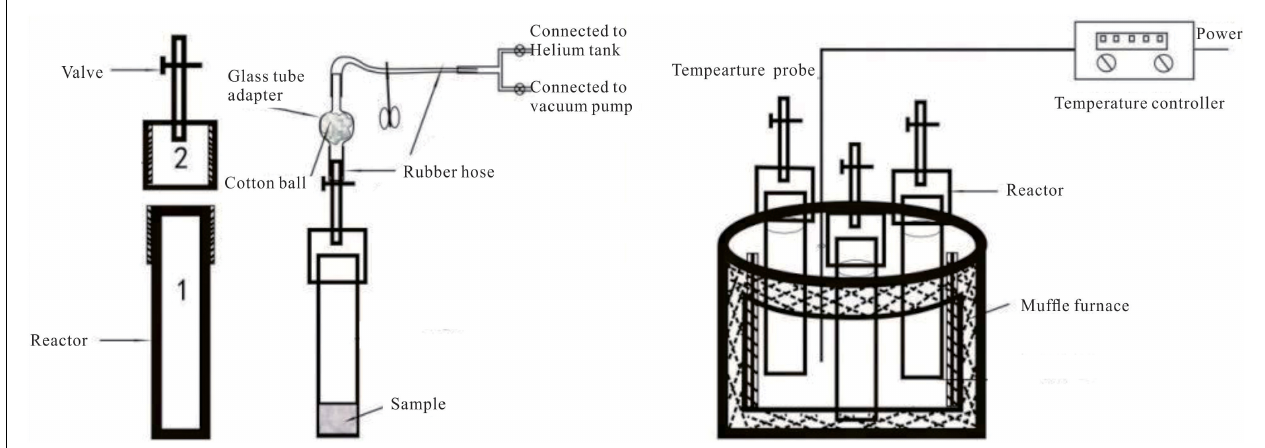
FIGURE 2 | Schematic diagram of the low-temperature thermal simulation experimental